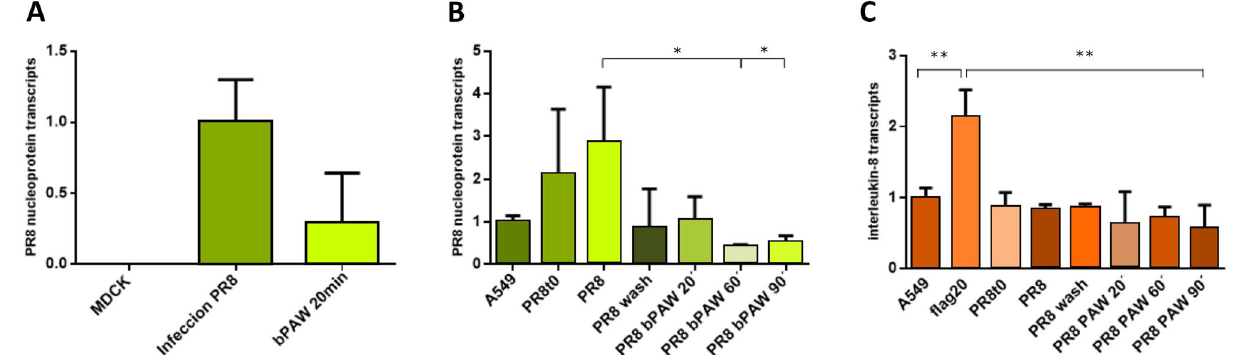
Figure 4. Effect of plasma activated water on infectivity and inflammation caused by influenza PR8 H1N1 virus. ( A ) Results of inhibition of PR8 H1N1 virus replication in the canine kidney MDCK cell line obtained after infection with PR8 and subsequent treatment with bPAW. The figure depicted the PR8 nucleoprotein transcript level (arbitrary units, a. u.). ( B ) bPAW Inhibition of the internalization of the PR8 virus measured by nucleoprotein RNA transcripts (a. u.). A549 human lung cells were subjected to PR8 H1N1 infection for 1 h and subsequently treated with bPAW for 20, 60 and 90 min. ( C ) Study of inflammation produced by bPAW treatment in the A549 human lung cell line. The panel denoted the normalized level of interleukin 8 RNA transcripts. All figures represent normalized values (Mean ± SD). Statistical analysis was carried out using one- way anova with Tukey’s post-hoc test, *p<0.01; **p<0.001. Generated with INKSCAPE 1.1 (www. inksc ape.